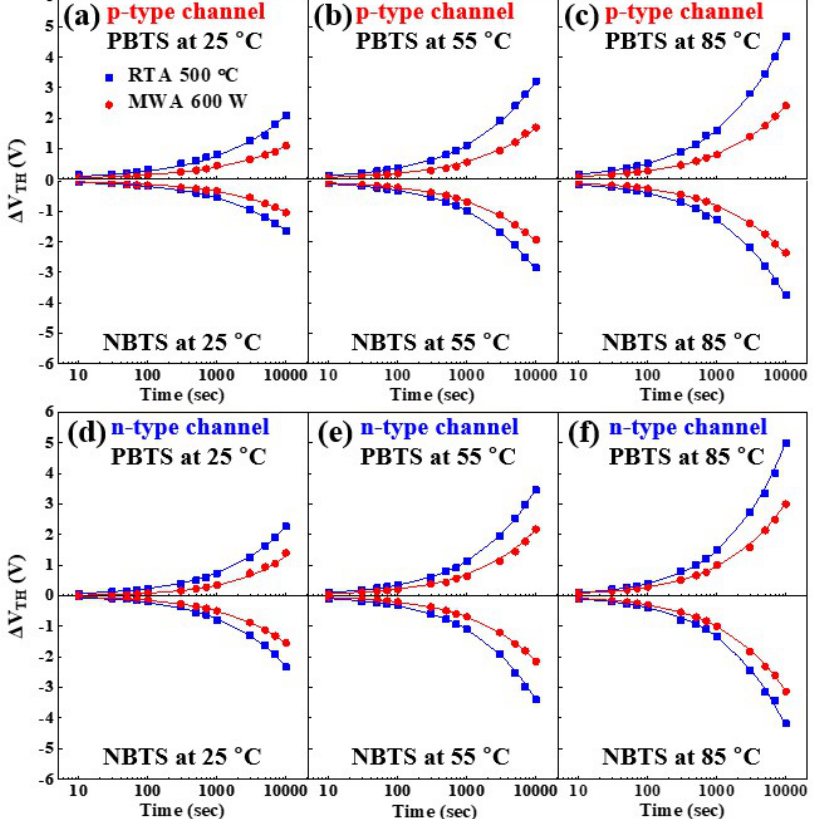
Figure 8. The temperature dependence of ΔV TH in the p-type channel (a–c) and the n-type channel (d–f) of the MWA and RTA NiSi x SB-TFTs during the PBTS (V G = +20V) and NBTS (V G = –20V) tests ( d – f ) of the MWA and RTA NiSi x SB-TFTs during the PBTS (V G = +20 V) and NBTS (V G = − 20 V) for 10 4 s: (a and d)25 °C, (b and e) 55 °C and (c and f) 85 °C. tests for 10 4 s: ( a , d ) 25 ◦ C, ( b , e ) 55 ◦ C and ( c , f ) 85 ◦